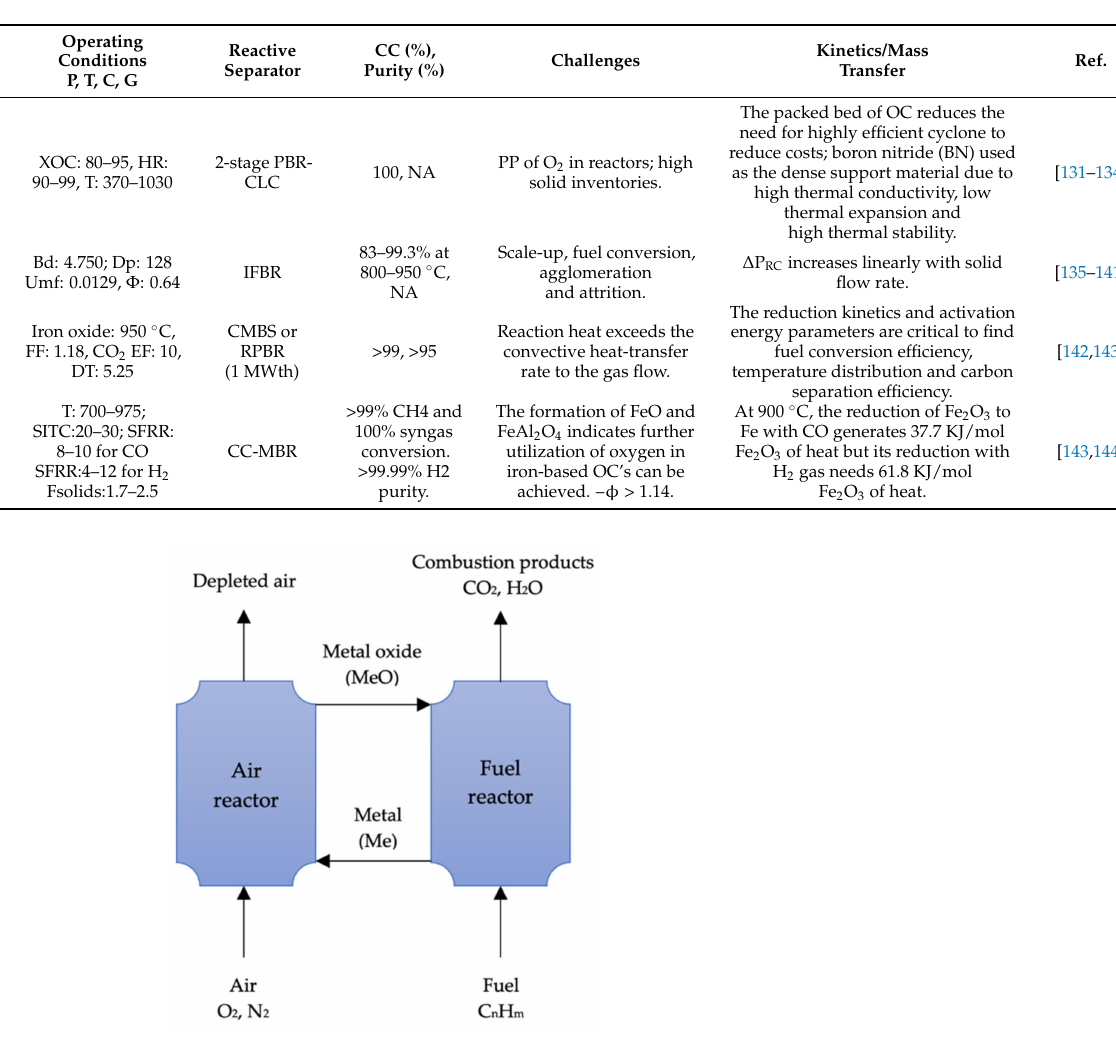
Figure 5. Schematic of chemical-looping combustion (adapted from Yang